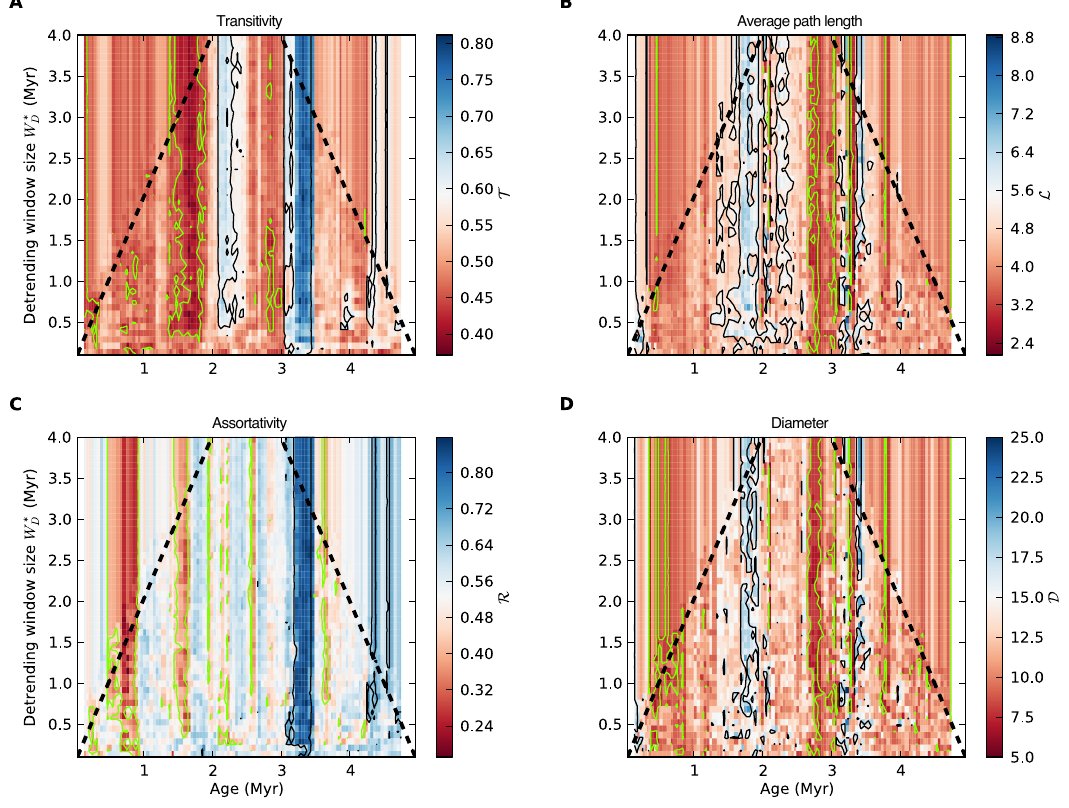
Fig. 14. Dependence of (A) transitivity T , (B) average path length L , (C) assortativity R , and (D) diameter D on the detrending window size W ∗ D for the dust flux record from ODP site 659. The recurrence window size is fixed to W ∗ =410 kyr with a step size of ∆ W ∗ =41 kyr. Green and black contours correspond to the 5% and 95% quantiles with respect to the test distribution obtained from 10000 realisations of our null-model. Other parameters were: embedding dimension m = 3 and delay τ ∗ = 10 kyr, the threshold was chosen to yield a fixed edge density ρ = 0 . 05. In regions outside the black dashed lines the results are influenced by boundary effects, since the effective detrending window size W D ( t ) has to decrease towards the time series’ limits (Eq. (3)). The white bands indicating “no value” at the left and right margins of each panel appear because we plot the network measures g µ,W ∗ at the mid-points t µ of the windows µ used for RN analysis (Sec. 2.4). In contrast to Fig. 13 their width does not change as W ∗ is fixed here.